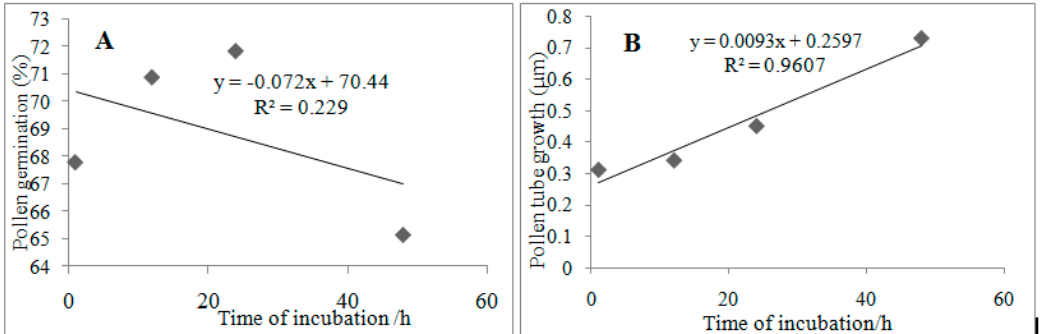
Figure 5. Relationships between the time of incubation, pollen germination, and tube growth. ( A ) Negative relationship between time of incubation and pollen germination, ( B ) Strong positive relationship between the time of incubation and pollen tube growth.